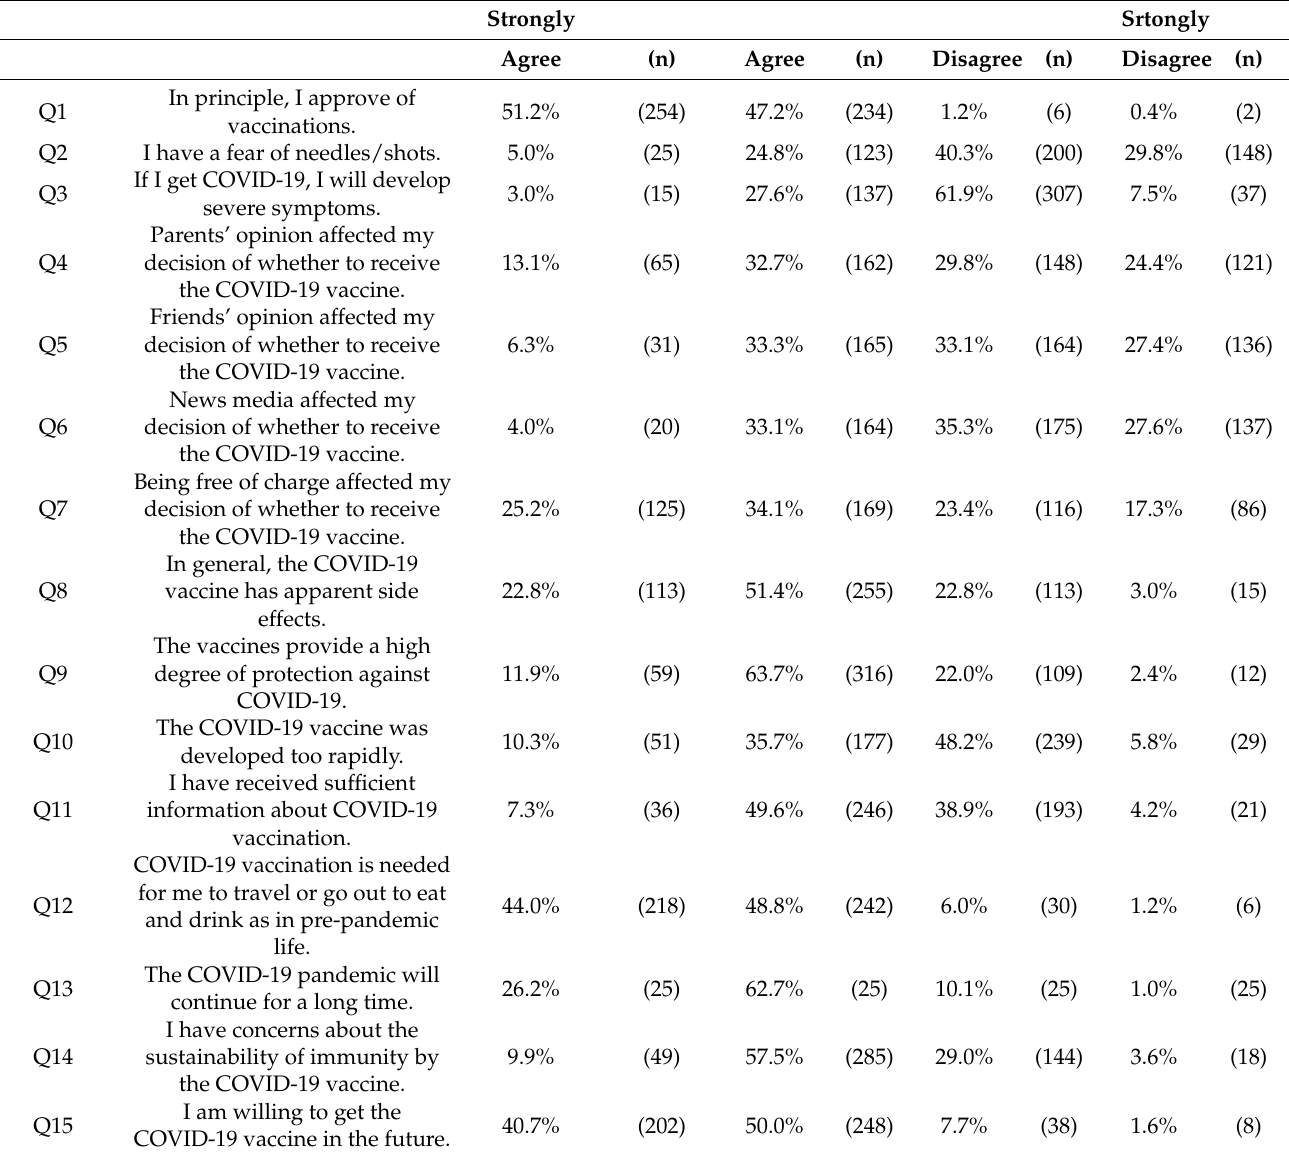
Table 1. Attitudes of medical students toward COVID-19 vaccination (n =